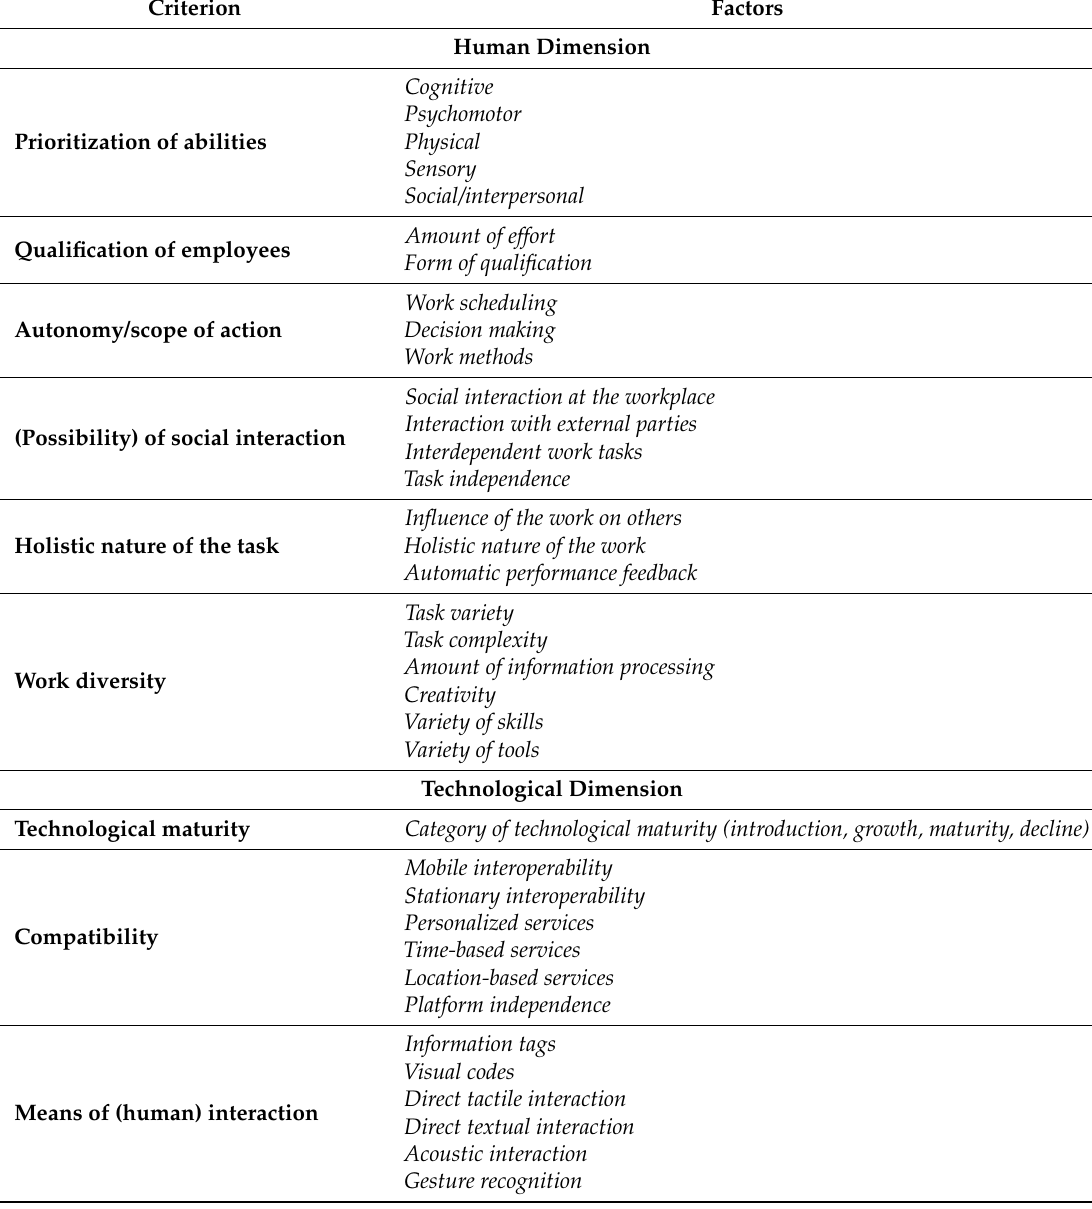
Table 1. Overview of the different criteria and the corresponding factors for the dimensions human, technology and